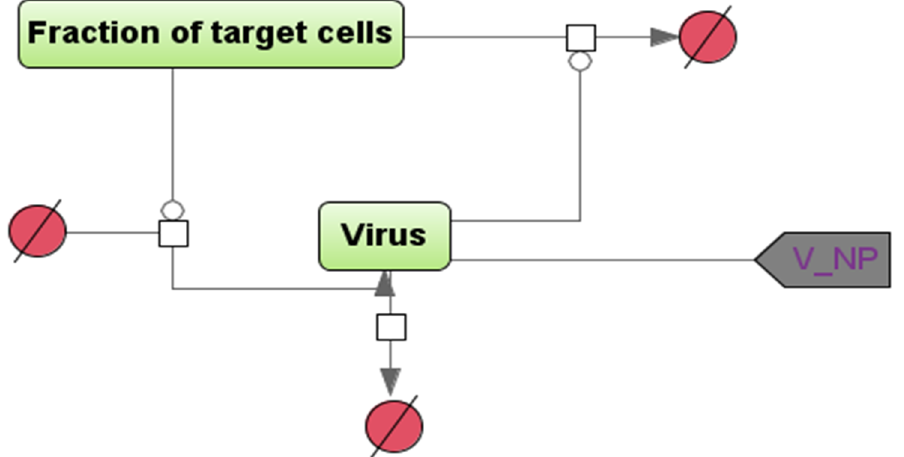
Figure 2. A schematic diagram describing the multiplication and inactivation of the virus in a certain compartment (the NP module is shown as an example), in the SBGN format [8]. “Fraction of target cells” is the proportion of cells sensitive to the infection, and “Virus” is the number of viral particles in a given compartment of the model. The vertices in the bipartite graph in the form of white squares correspond to the reactions in the model, the rate equations of which are given below in the system of ordinary differential equations. To account for the transport of viral particles from the NP module to the intestine and lung, a “contact”-type port (gray color) is used within the modular approach in BioUML.